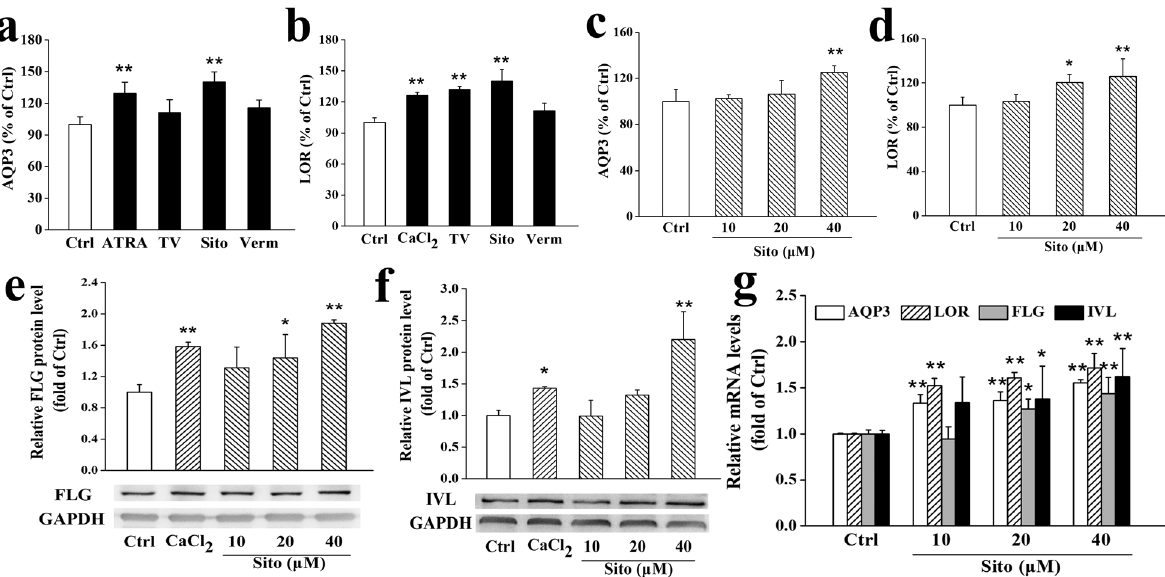
Figure 3 - Effects of compounds on the expression of AQP3, LOR, FLG and IVL in HaCaT. The protein expression of AQP3 ( a, c ) and lOR ( b, d ) was measured by elISA. The protein expression of Flg ( e ) and IVl ( f ) was measured by western blot. The mRNA expression of AQP3, lOR, Flg and IVl ( g ) was measured by qRT-PCR. * P < 0.05 and ** P < 0.01 vs. Ctrl